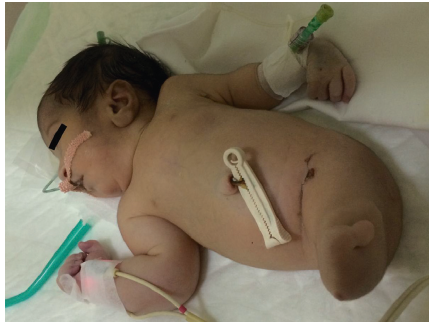
Figure 2: Sirenomelic baby with fused lower extremities and absent feet.